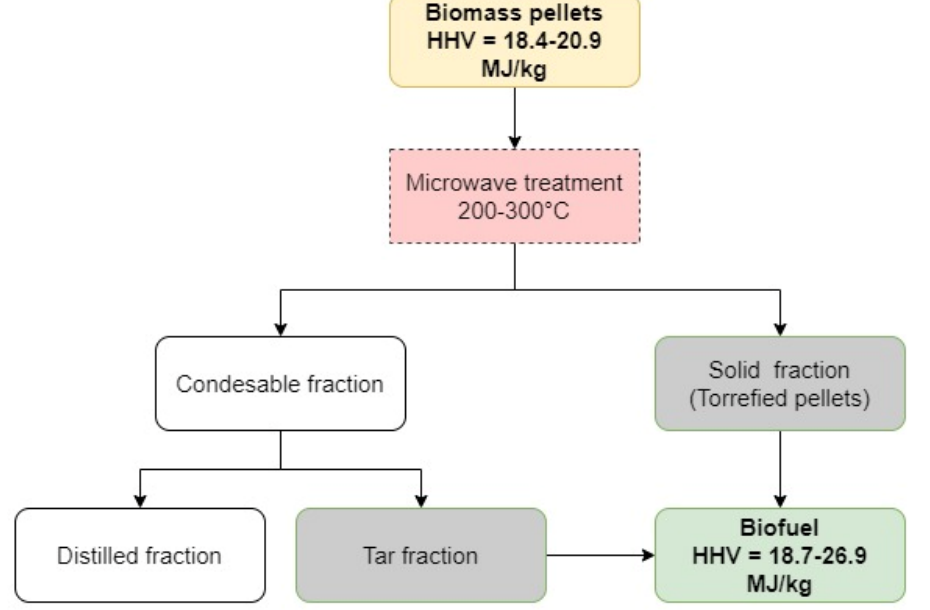
Figure 1. Schematic diagram of the performed experiments.